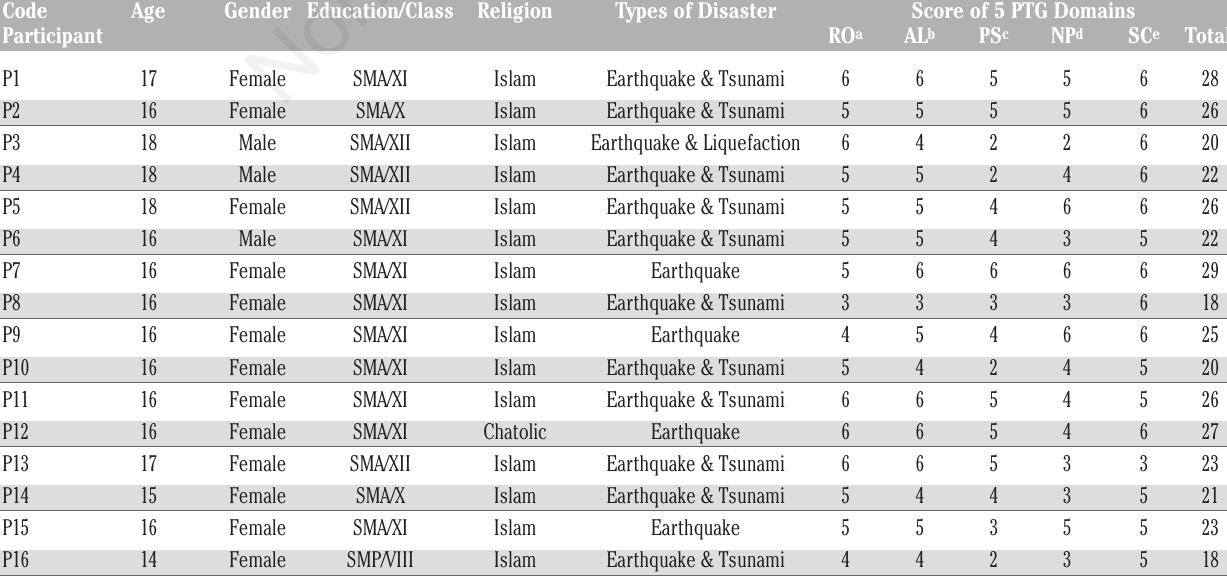
Table 1. Characteristics of adolescent survivors (N=16).